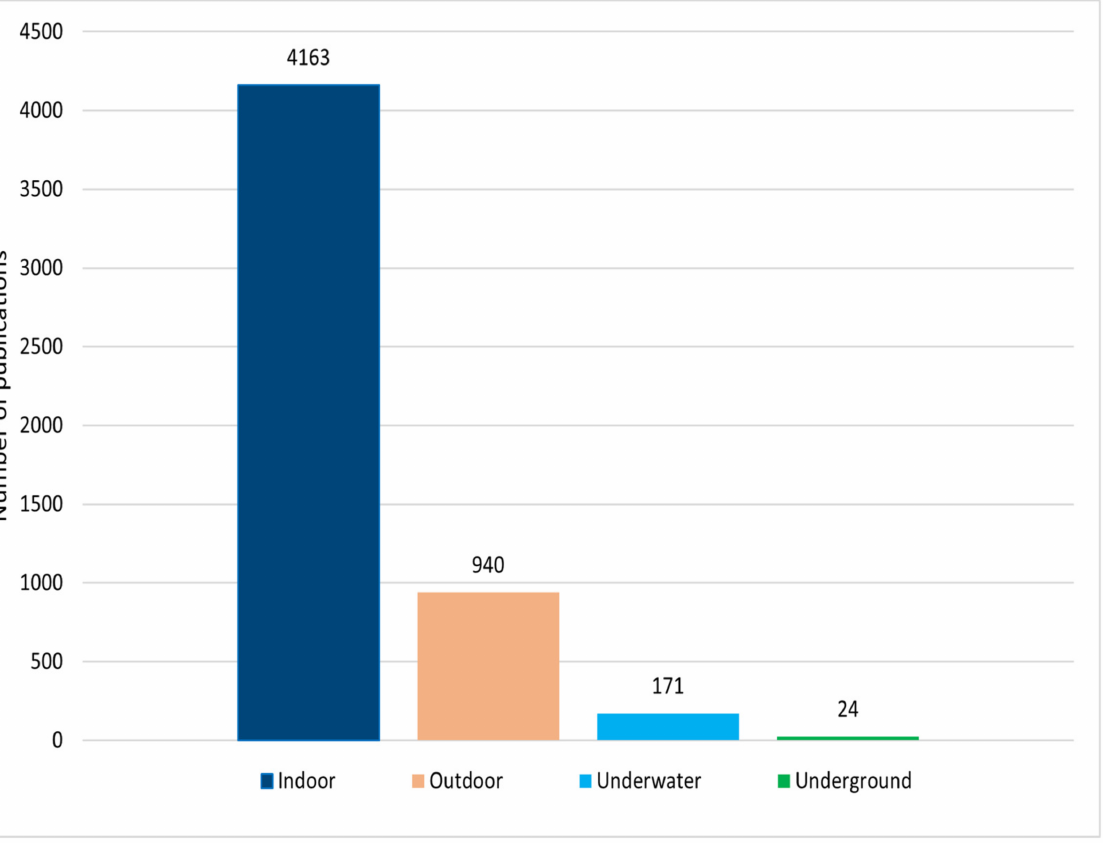
Figure 3. Number of publications on different VLC environments from several journals (IEEE, MDPI, Elsevier and OSA) from 2003 to